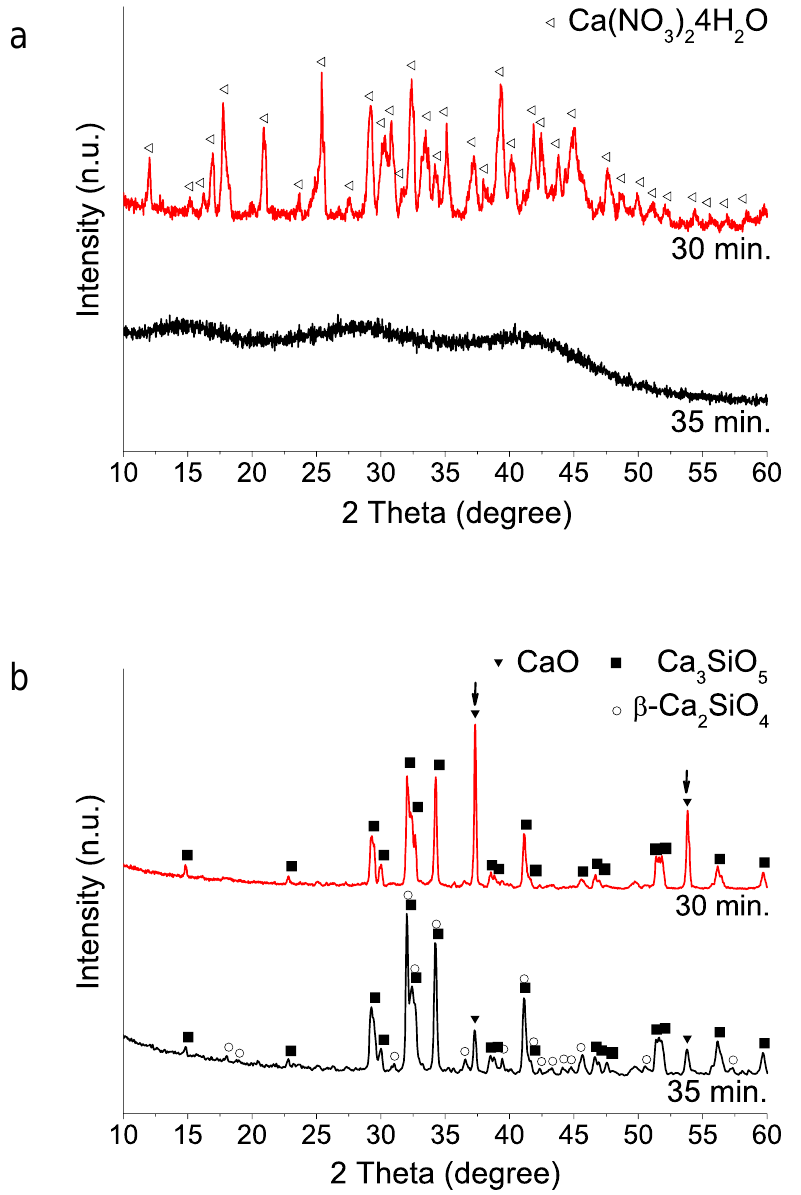
Figure 1. XRD patterns of sol–gel BEC preparations using different TEOS hydrolysis step times: ( a ) as synthesized powders (without heating treatment); ( b ) after heat treatment at 1400 ◦